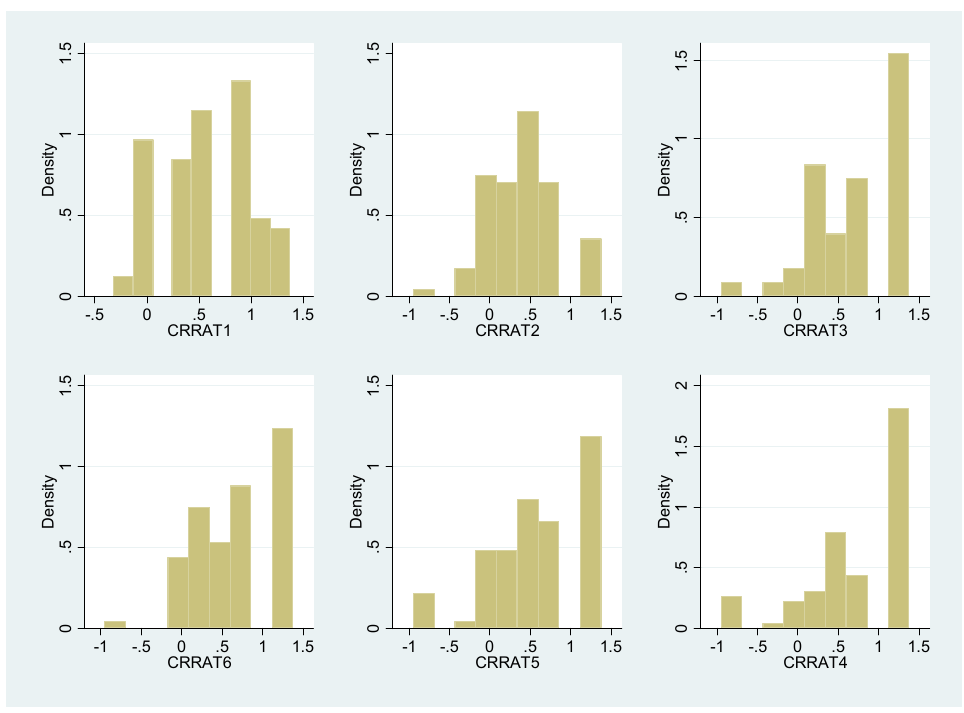
Figure A4. Histograms of the CRRA exhibited by the subjects, which represent the distributions of the degrees of risk aversion.